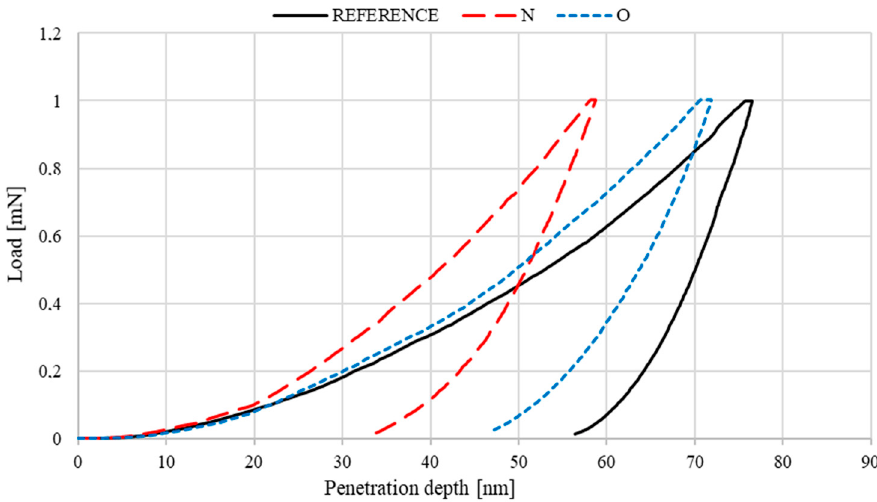
Figure 9. Loading–penetration depth curve from nanohardness tests. Table 5. Mechanical parameters.